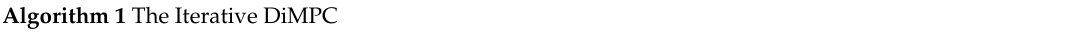
Algorithm 1 The Iterative